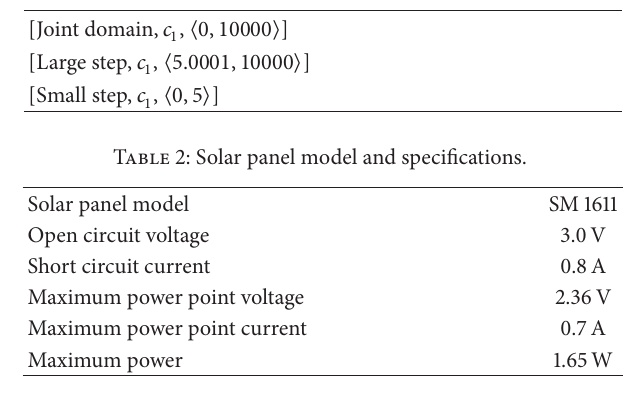
Table 1: Matter-element model of the extension incremental con- ductance method for 𝑑𝑃/𝑑𝑉 .